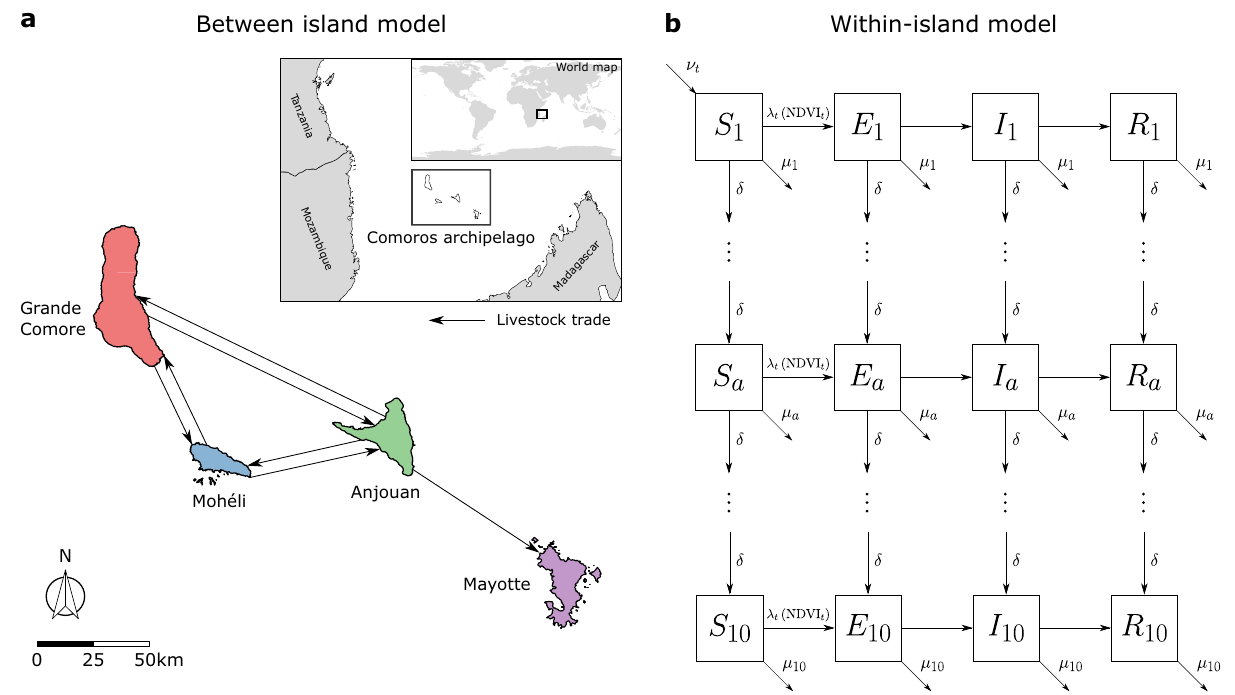
Fig. 1 Metapopulation model for RVF virus transmission in the Comoros archipelago. In order to quantify the drivers of Rift Valley fever in the Comoros archipelago, we developed a metapopulation model describing RVF virus infection of livestock (cattle, sheep and goats) in the Comoros archipelago. a We modelled the explicit movement of livestock (solid black arrows) between the four islands in the Comoros archipelago: Grande Comore (red), Mohéli (blue), Anjouan (green) and Mayotte (purple). b Within-island viral transmission was modelled as an age-strati fi ed Susceptible-Exposed-Infected- Recovered (SEIR) model. The shown schematic illustrates the transfer of animals (arrows) between four infection states – susceptible, S , exposed, E , infected, I , and recovered, R – and 10 age groups, a = 1, ..., 10, (boxes) on each island. The number of individuals in each compartment was updated in discrete time, t , with a single time step equal to one epidemiological week. Animals were born into the youngest age group at a time-varying rate ν t and were removed from the system due to death at an age-dependent proportion μ a . A fi xed proportion, δ , of individuals were aged at each time step. Susceptible animals were exposed to the disease at a time-varying proportion, λ t , which was dependent on the mean Normalized Difference Vegetation Index (NDVI) across each island and time point. For further details on the metapopulation model, please refer to the Methods section. Data used to produce the maps shown in ( a ) were made available under Attribution 3.0 Unported (CC BY 3.0) 67 and Creative Commons Attribution for Intergovernmental Organisations (CC BY-IGO) 68 licenses. The former (CC BY 3.0) licenced the data for Mayotte 69 , and the latter (CC BY-IGO) licenced the data for the Union of Comoros 70 , Tanzania 71 , Madagascar 72 and Mozambique 73 . All presented data was